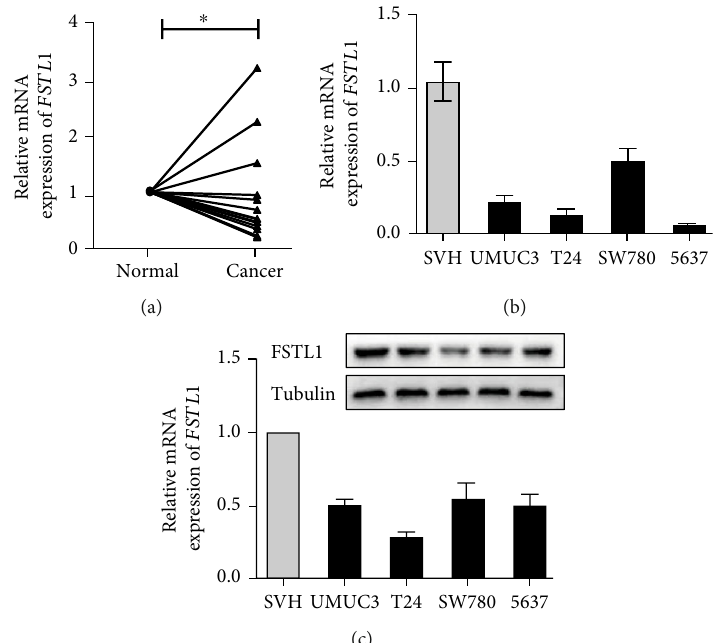
Figure 7: FSTL1 expression was detected in bladder cancer tissues and cell lines. (a) Relative mRNA expression of FSTL1 in fi fteen BC tissues and their adjacent normal tissues was examined by RT-qPCR (normalized to β -actin). (b, c) The relative expression of FSTL1 in the SV-HUC-1 cell line and four human BC cell lines was tested by (b) RT-qPCR and (c) Western blot. ( ∗ p value < 0.05, ∗∗ p value < 0.01, ∗∗∗ p value < 0.001, and # p value ≥ 0.05). t -test was performed to analyze statistical signi fi cance. Values are presented as mean ± SEM